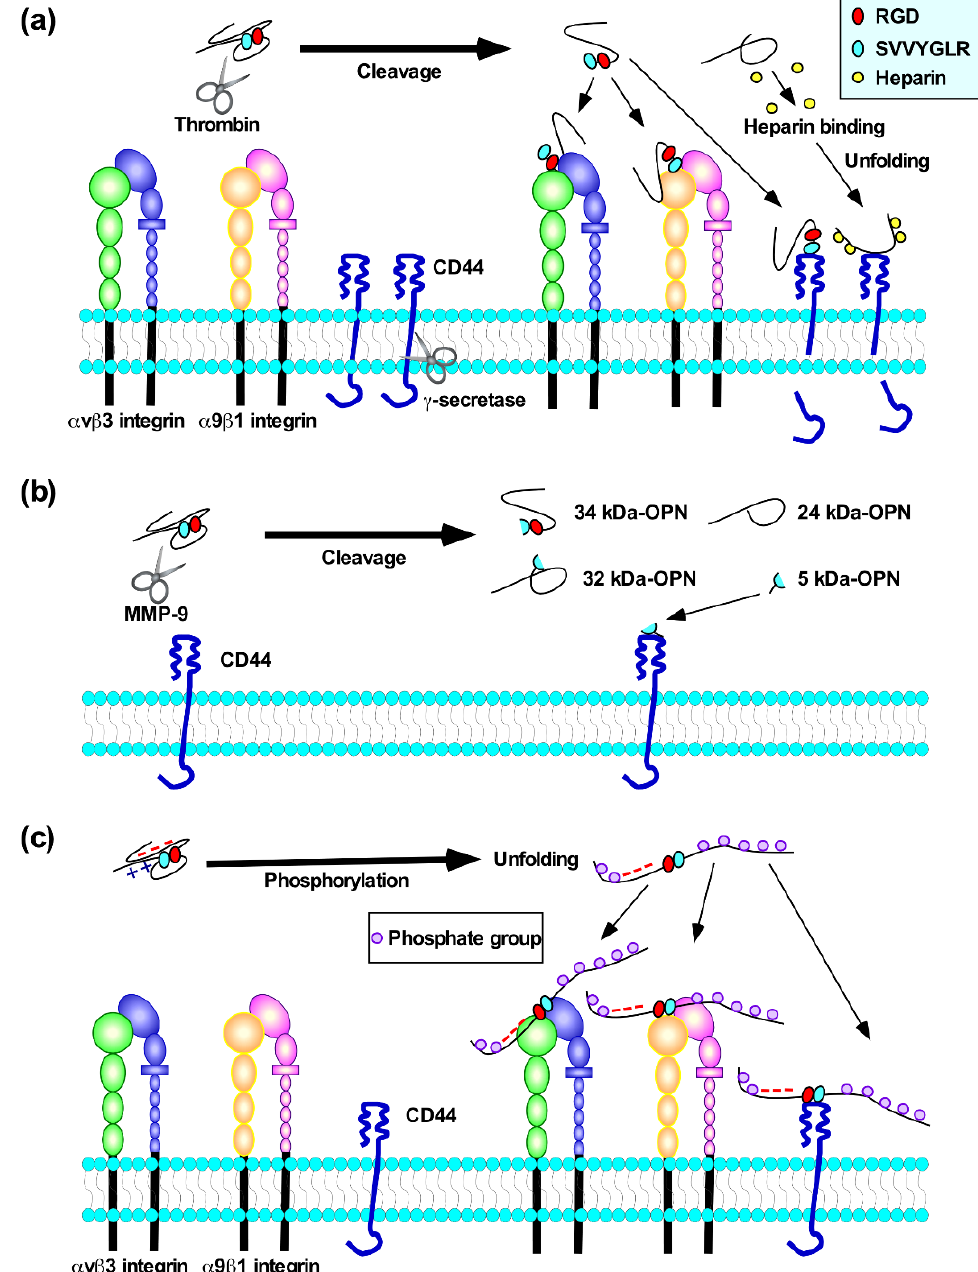
Figure 3. Post-translational modifications of osteopontin (OPN) and its interactions with receptors in cancer progression. ( a ) After cleavage of OPN by thrombin, N-terminal fragment may associate with α v β 3 and α 9 β 1 integrins as well as CD44, while the C-terminal fragment bound to heparin may associate with CD44. ( b ) Cleavage of MMP-9 generates four OPN fragments, and a 5 kDa-OPN fragment may bind to CD44. ( c ) Phosphorylation of OPN may inhibit the internal interaction, probably between positive and negative charge residues, leading to unfolding, and then associate with integrins and/or CD44.